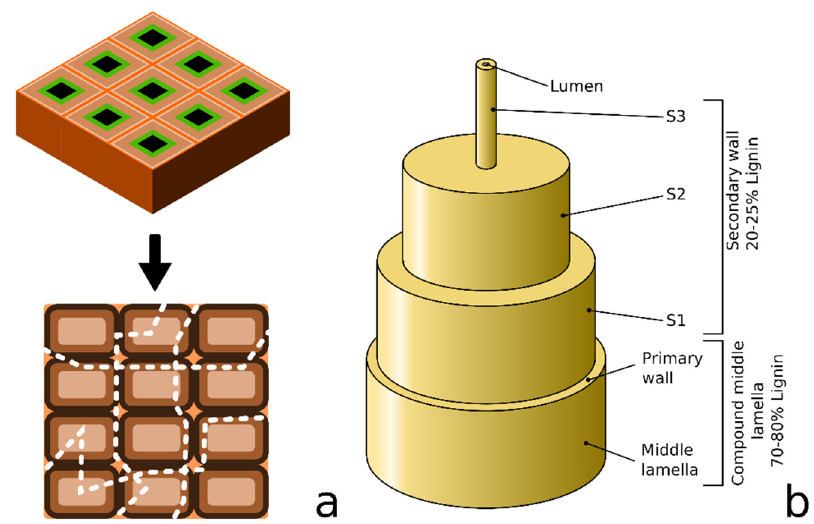
Figure 3. ( a ) Mechanism through which fibers are separated during mechanical fibrillation and ( b ) Scheme of natural fiber structure.